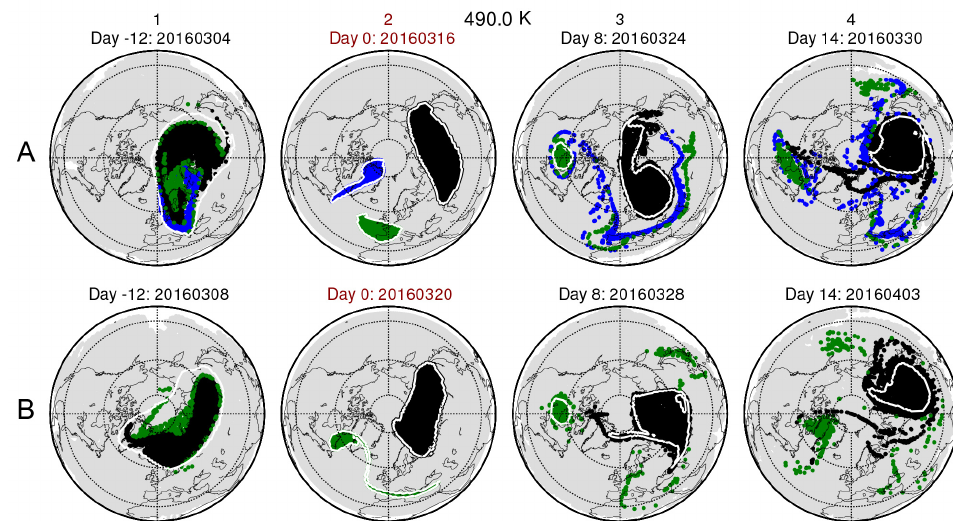
Figure 12. Trajectory-based parcel history maps at 490K showing the locations of air parcels initialized inside vortex regions as defined by CAVE-ART on 16 March (row A) and 20 March (row B). Parcels are colored black (parent), green (offspring-p), or blue (offspring-s) if they were inside a valid vortex region on the initialization date (column 2, red labeling); otherwise the parcels are colored grey. Columns 1, 3, and 4 show the locations of these parcels 12 days before and 8 and 14 days after initialization, respectively. The white contours show the vortex regions identified by CAVE-ART in MERRA-2 data (subsampled to match the 1.25 ◦ × 1.0 ◦ longitude–latitude grid used by the trajectory runs) on each date. Maps show Equator to pole, with 0 ◦ longitude at the bottom and 90 ◦ E to the right.